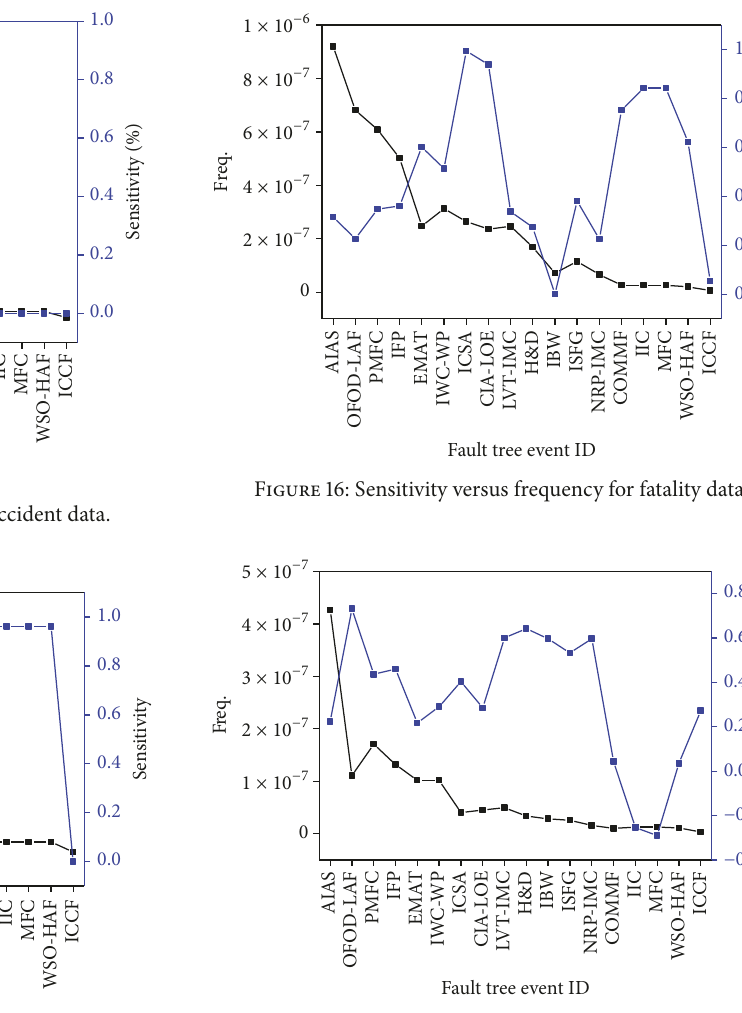
Figure 17: Sensitivity versus frequency for risk reduced